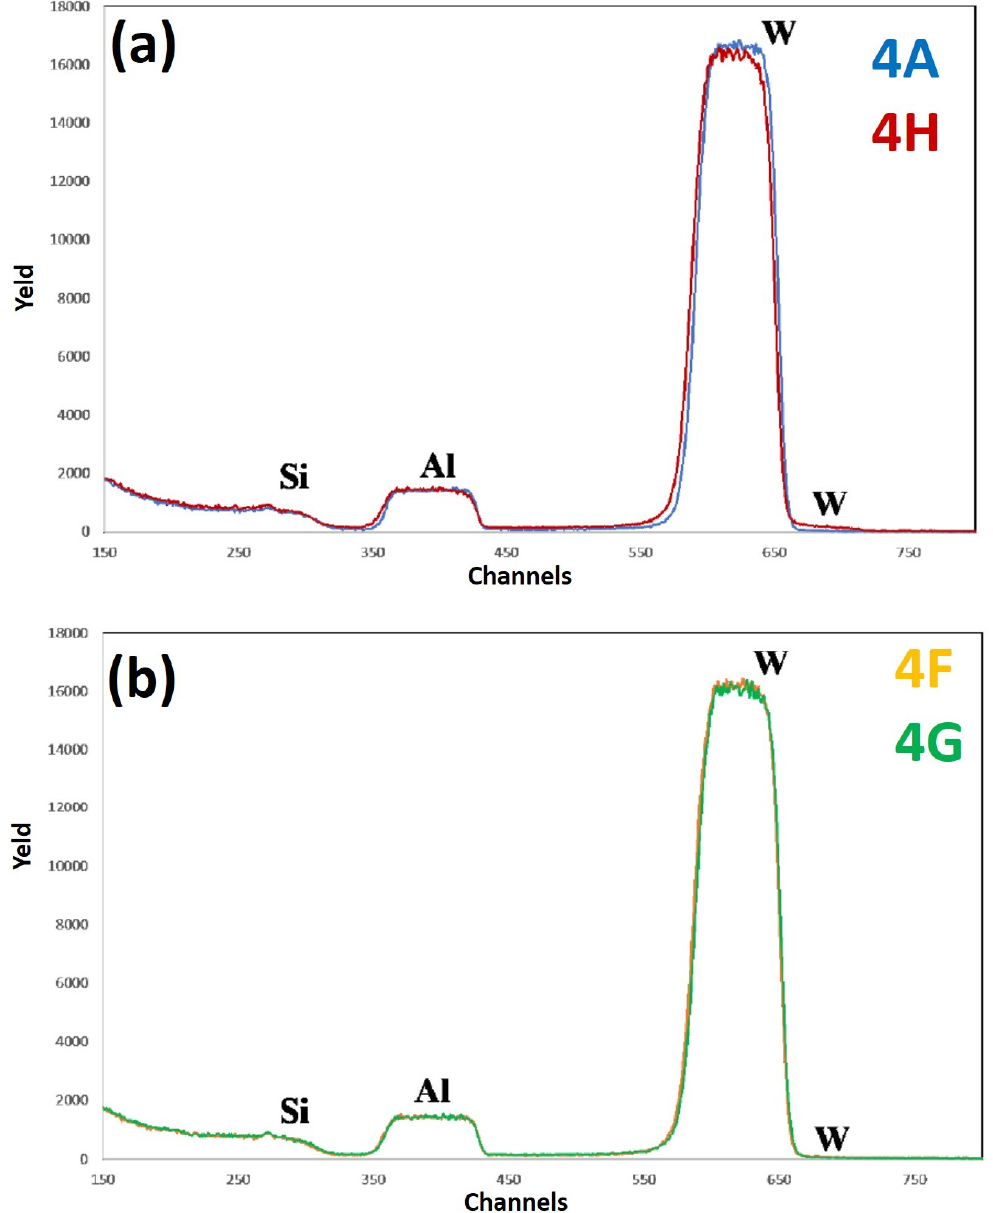
Figure 13 . RBS spectra of the samples: ( a ) 4A (Si/WN/Al)—blue curve, and 4H (Si/WN/Al + 500 °C 15 min)—red curve; ( b ) 4F (Si/WN/Al + 400 °C 15 min)—yellow curve, 4G (Si/WN/Al + 450 °C 15 min)—green curve. The curves are reported in different plots to easily identify characteristic features and differences.